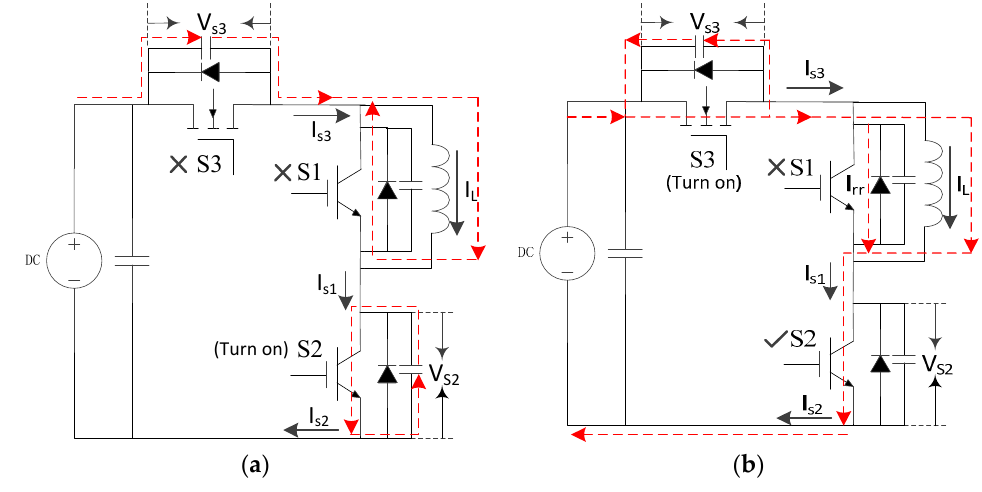
Figure 4. Turn-on period ( a ) Stage 4-at t2; and, ( b ) Stage 6-at t3.